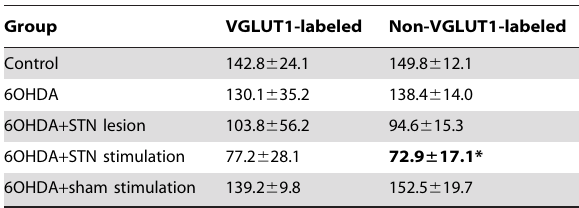
Table 2. Density of immuno-gold-labeled glutamate particles in post-synaptic spines in which presynaptic terminals were VGLUT1-labeled or